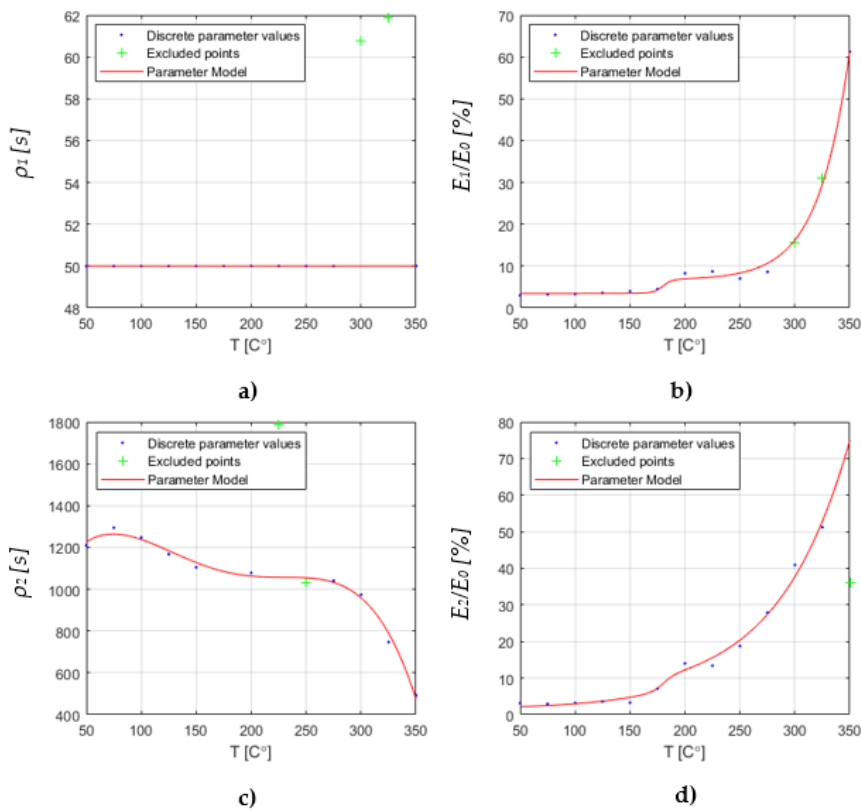
Figure 6. Resulting values of the element parameters of the Maxwell Model and the parametric fit for a continuous description [15]. It shows the decay time ρ i ( a ): branch 1, ( c ): branch 2 and the spring constant E i compared to the sum of all spring constants E 0 ( b ): branch 1, ( d ): branch 2.